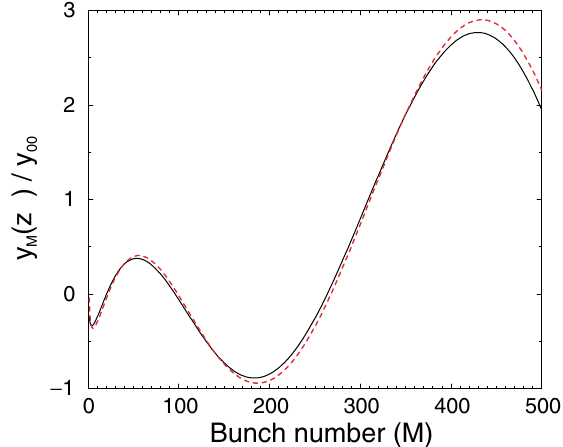
(cid:5) z (cid:6) =y for the case of single-bunch M 00 . The solid B